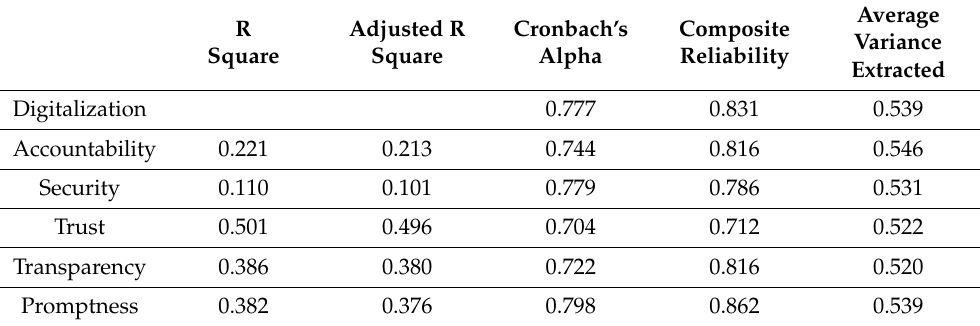
Table 2. The Model’s Reliability and